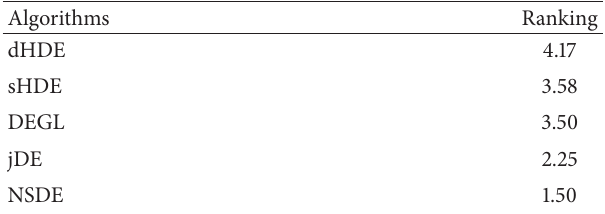
Table 4: Average rankings achieved by Friedman